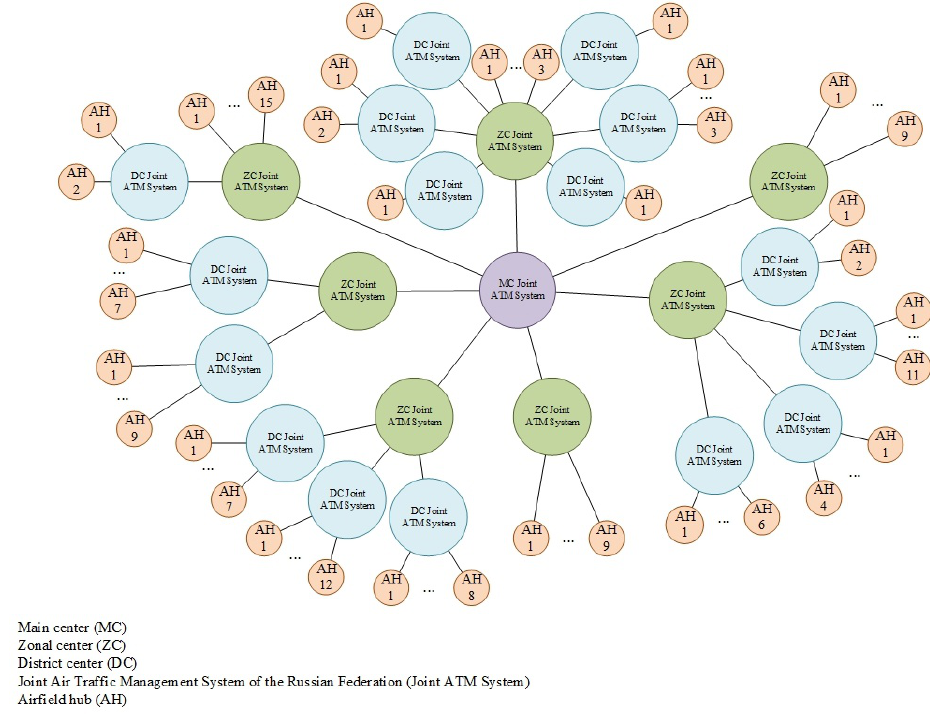
Figure 6. The structure of the operational bodies of the unified ATM system until 15 June